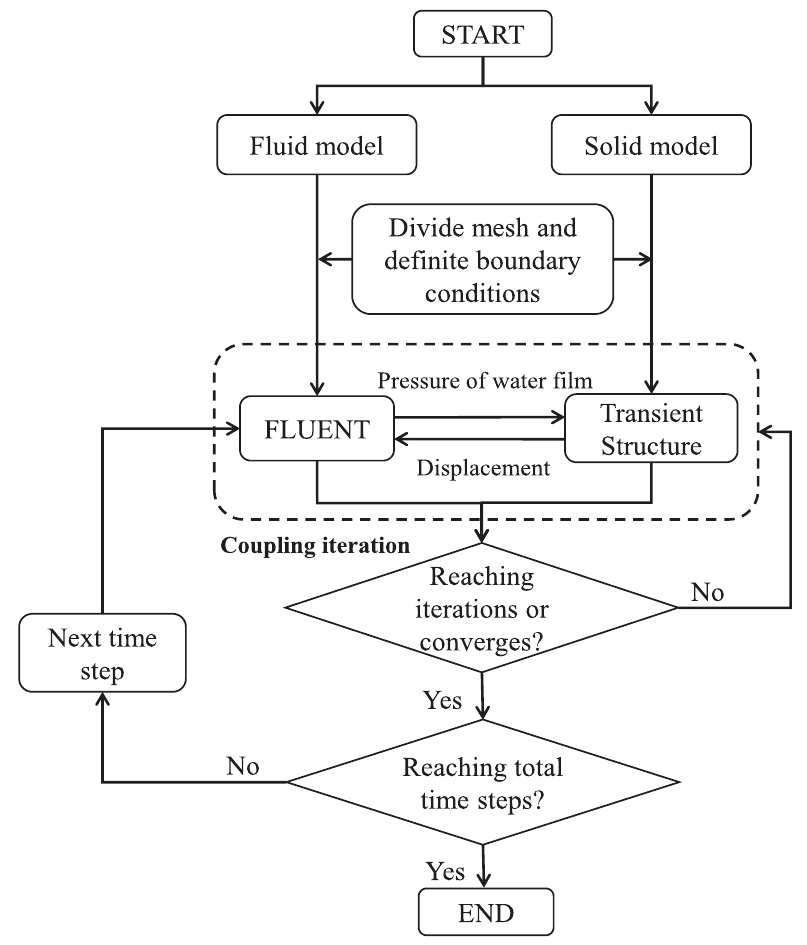
Fig. 2. Flowchart of calculation